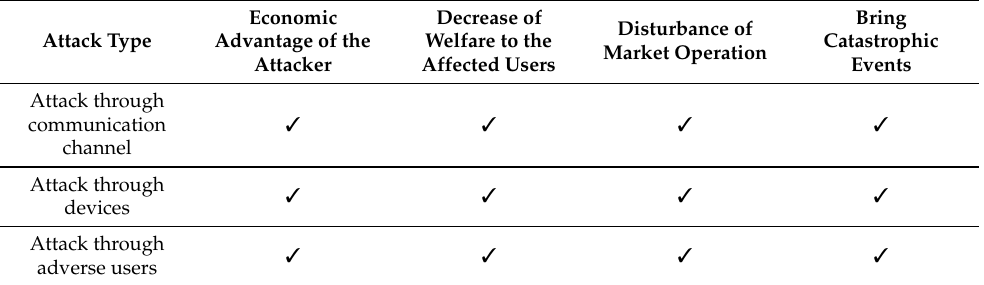
Table 1. Impact of Attacks in the transactive energy market (TEM)-based microgrid system. Attack